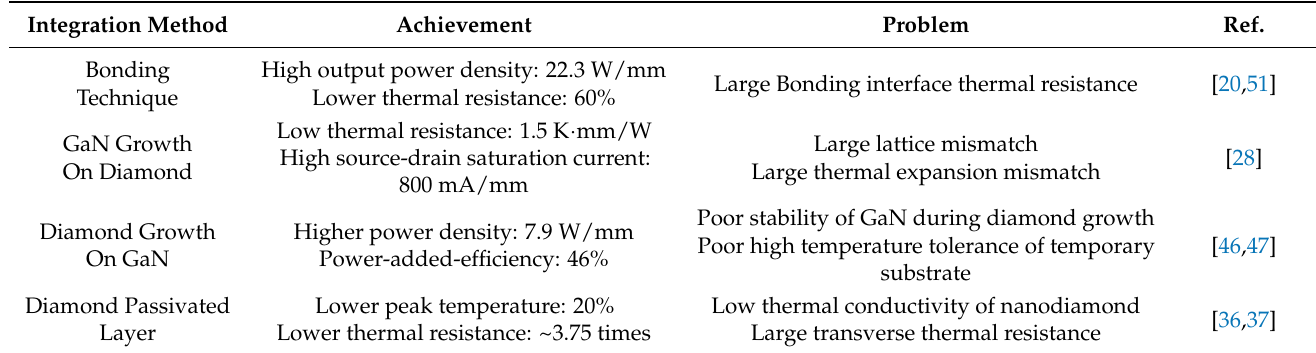
Table 3. Comparison of different Integration